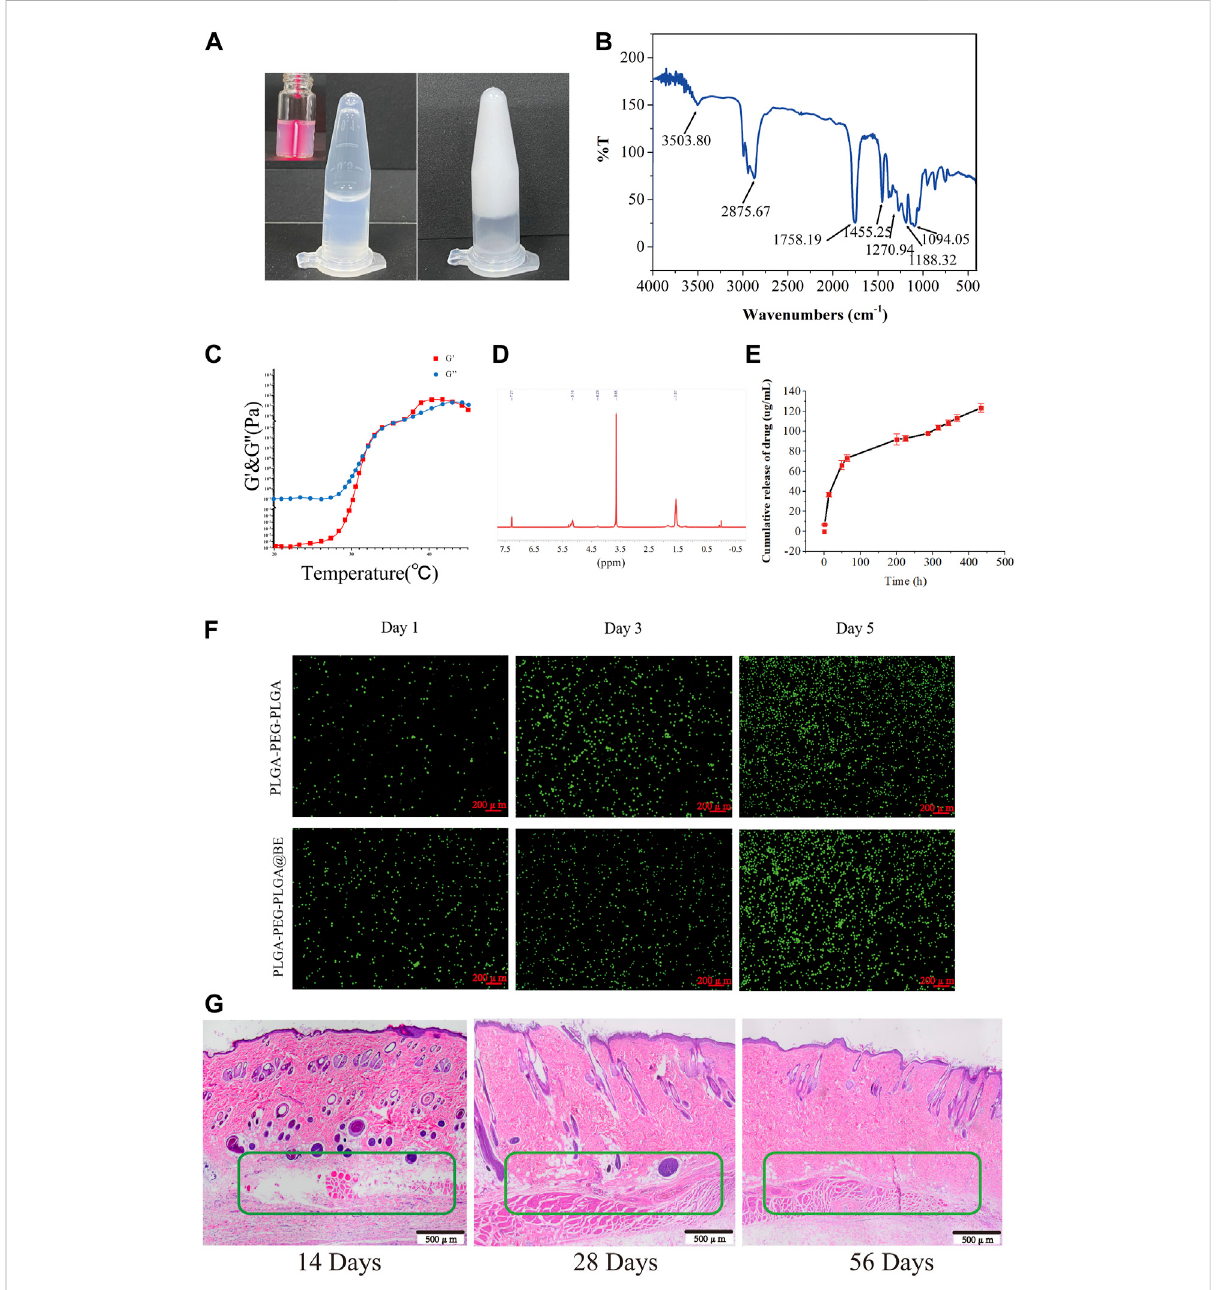
FIGURE 3 Controlledreleaseofbevacizumabfromthermosensitiveinjectablehydrogelswithbiocompatibility. (A) Sol-gelphasetransfermeasurementof PLGA-PEG-PLGA copolymers at 37 ° C using the vial inversion test. (B) FTIR transmission spectra of PLGA-PEG-PLGA-bevacizumab hydrogel. (C) Storage modulus G ′ and loss modulus G ″ of the PLGA-PEG-PLGA in PBS (20%). (D) The 1 H NMR spectrum of the PLGA-PEG-PLGA triblock copolymer. (E) Release curve of bevacizumab releasing from PLGA-PEG-PLGA hydrogel at 37 ° C. (F) Live/dead dyeing of NP cells in rats incubated on PLGA-PEG-PLGA hydrogels and PLGA-PEG-PLGA-bevacizumab hydrogels on day 1, 3 and 5, respectively. Red fl uorescent cells indicate dead cells and green fl uorescent cells are surviving. Scale bar = 200 um. (G) H&E staining of subcutaneously implanted PLGA-PEG-PLGA- bevacizumab hydrogels on postoperative days 14, 28, and 56. The green box indicates subcutaneous hydrogel. Scale bar = 500 um. data are expressed as mean ± SD (n =